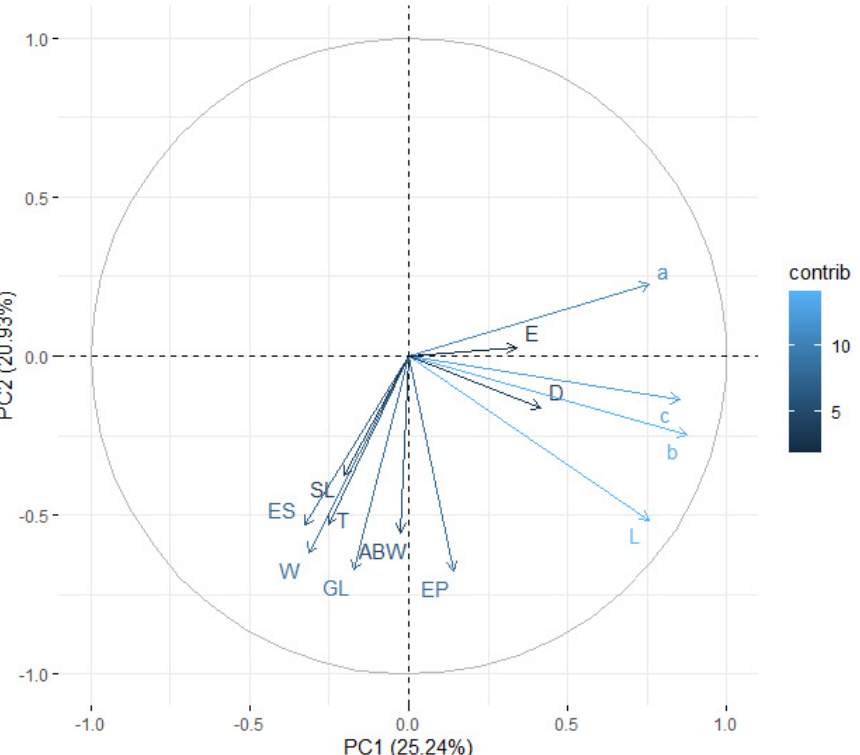
Figure 4. Principal component analysis of morphometric variables for first-stage adult males.